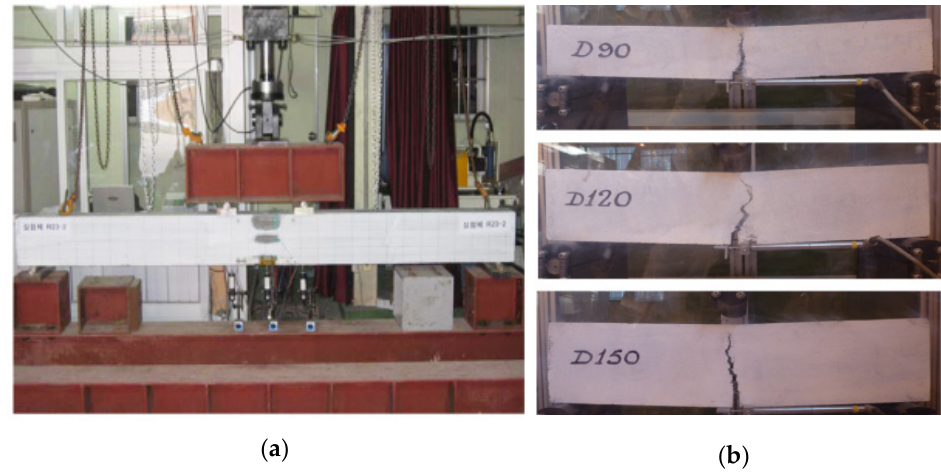
Figure 6. Evaluation of the flexural strength of UHPFRC. ( a ) Four-point bending test set up and ( b ) formation of cracks and UHPFRC failure in flexure ([33,58]—Elsevier Copyright).